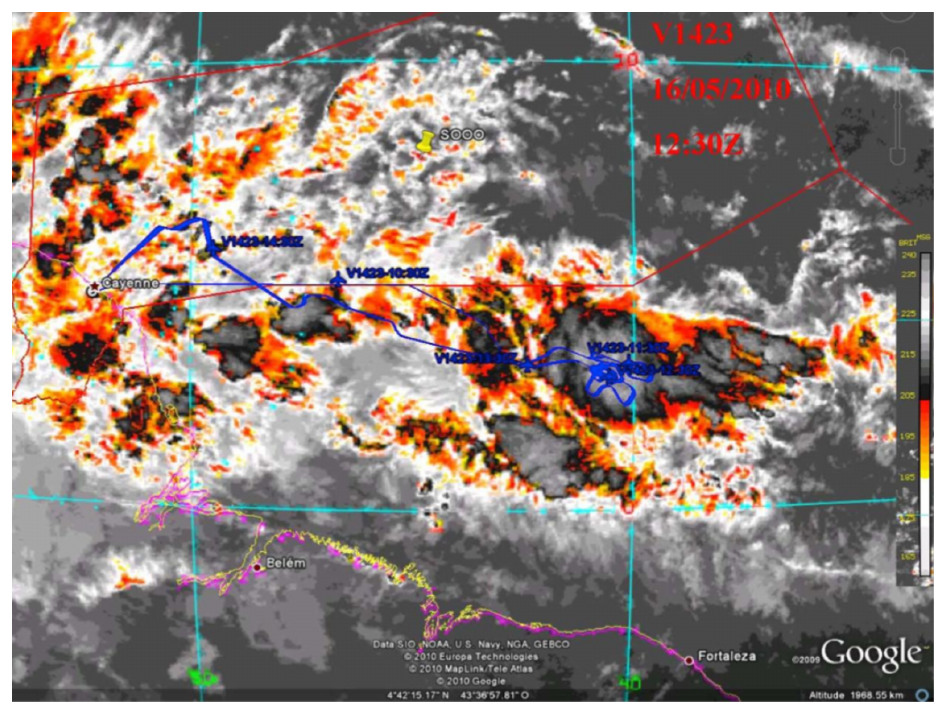
Figure 3. Cayenne flight F1423 track over brightness temperature from Meteosat 9 channel 10 at 12:45UTC on 16 May 2010.